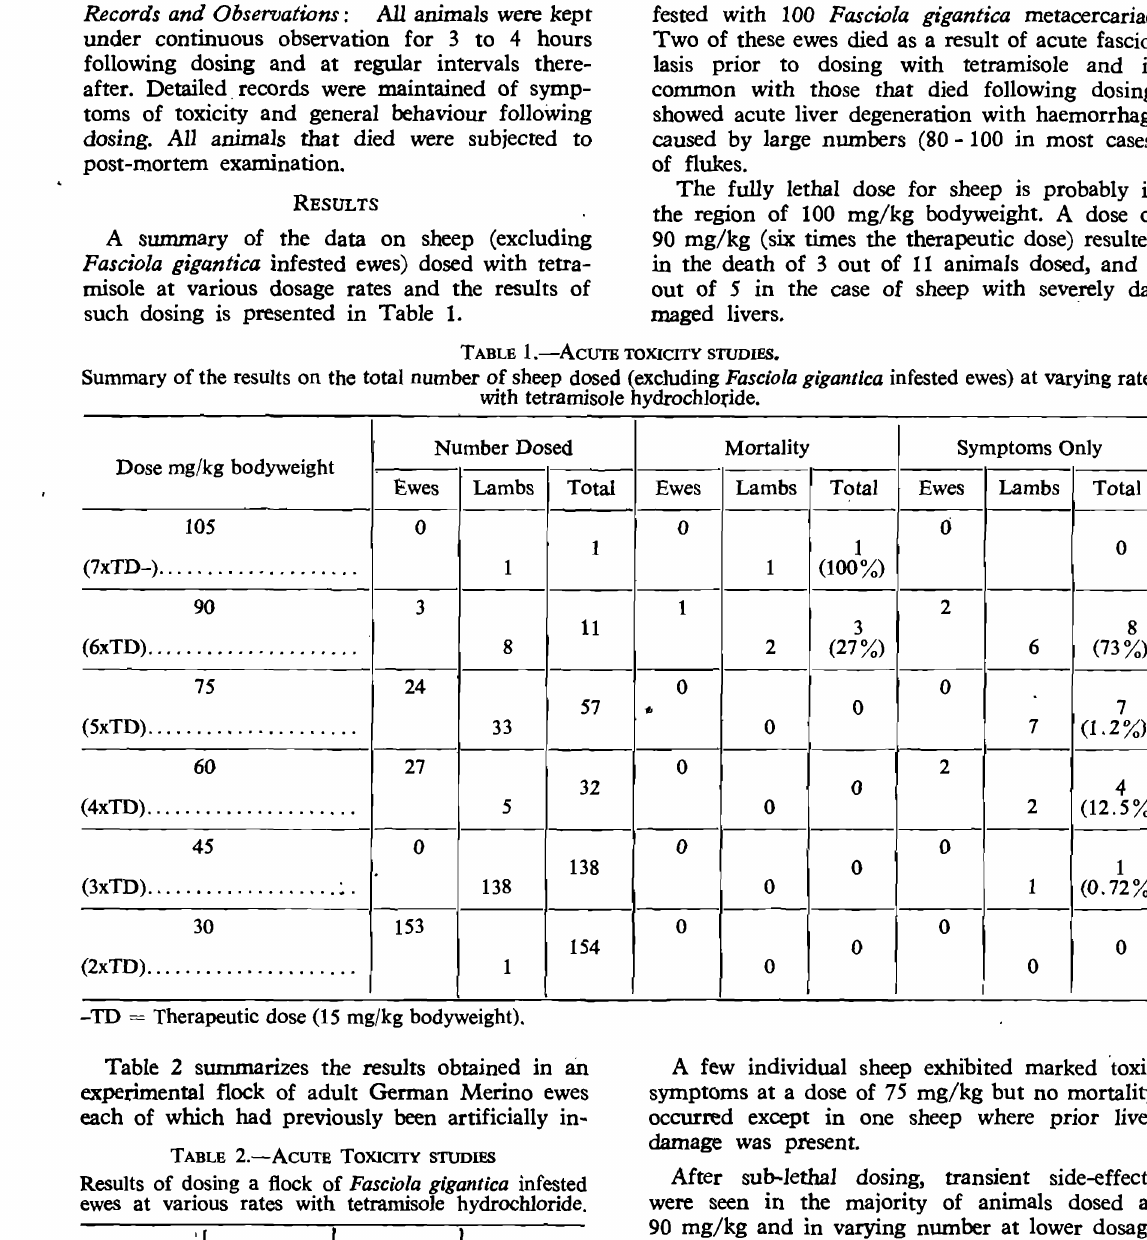
TABLE 2.-AcUTIl TOXICITY